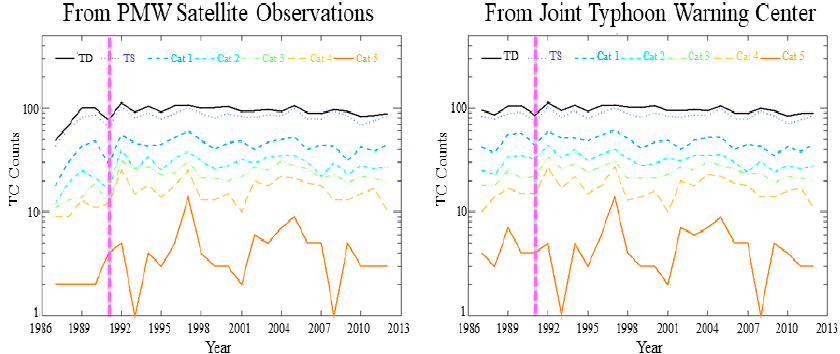
Figure 2. Annual variability of TC activities at each category. Left panel is from the PMW sensor observations while right panel is from Joint Typhoon Warning Center (JTWC). The vertical dashed line is a mark of 1991 which was for start of at least two PMW sensor observations.